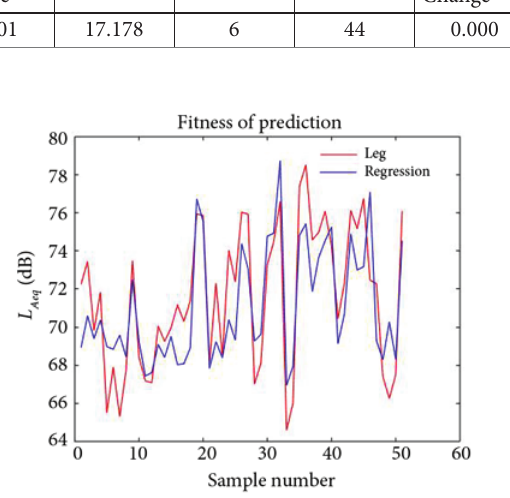
Figure 13. Comparing results of regression model and